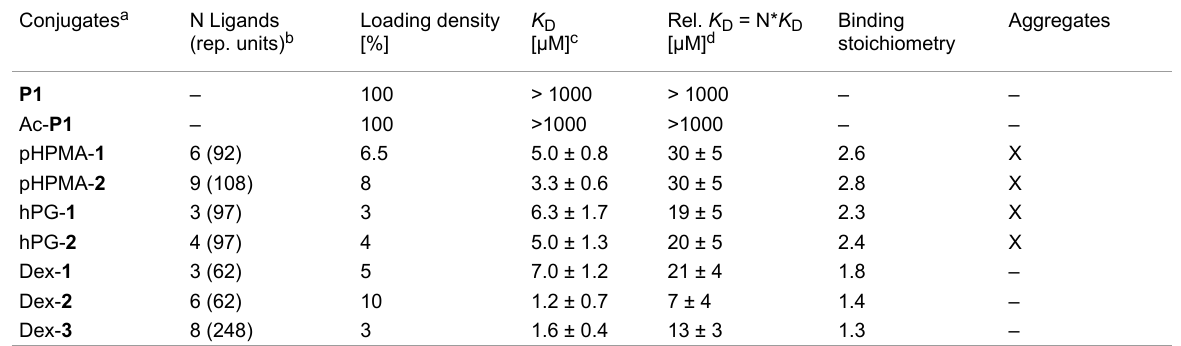
Table 1: ITC measurements of peptide–polymer conjugates with tandem WW domain of FBP21. Conjugates a